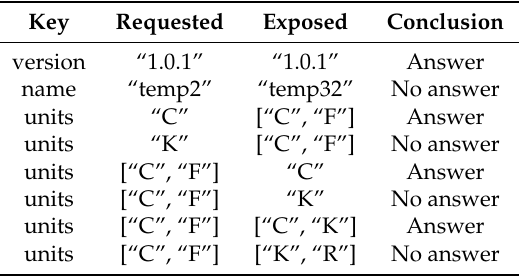
Table 4. An example of the discovery decision